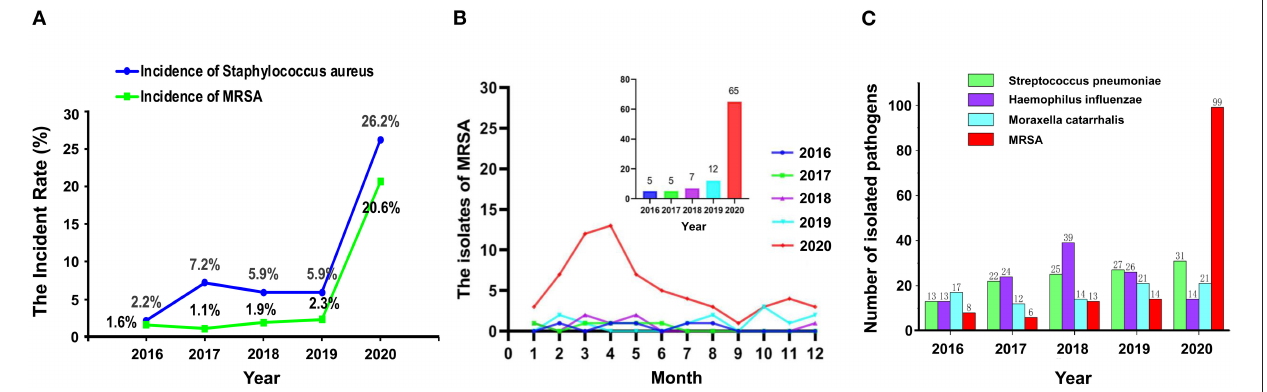
FIGURE 1 | The detection rate of Staphylococcus aureus and methicillin-resistant S. aureus (MRSA) (A) , the isolates of MRSA (B) , and the number of pathogenic bacteria (C) isolated from respiratory specimens from 2016 to 2020.